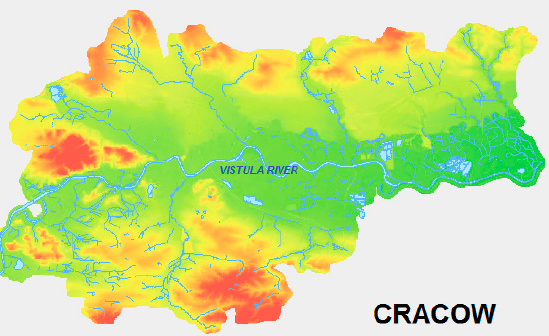
Figure 2. Hipsometric map of Cracow (Source: own elaboration based on https://obserwatorium.